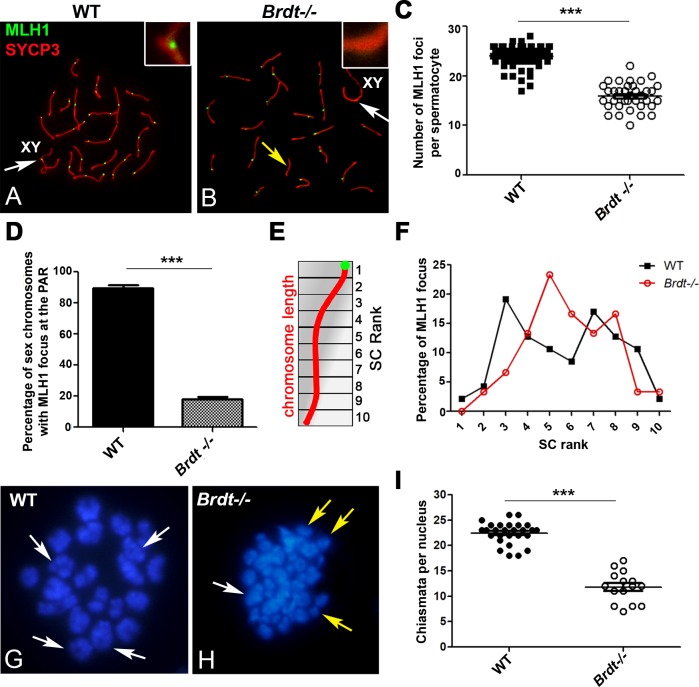
BRDT is required for the formation and distribution of CO during pachynema and chiasmata in metaphase.(A, B) Immunolocalization of MLH1 (green) and SYCP3 (red) in WT (A) and Brdt-/- (B) spermatocytes. Insets enlarge the PAR. White arrow indicates the presence or absence of the MLH1 focus in the PAR. Yellow arrow in (B) indicates autosomes with no MLH1 foci. (C) Quantification of the number of MLH1 foci per nucleus in WT (black squares) and Brdt-/- (white circles) pachytene spermatocytes. ***p<0.0001. Error bars represent standard deviation. Samples were obtained from three mice per genotype. n = 45 and 39 WT and Brdt-/- spermatocytes, respectively. (D) Quantification of sex chromosomes with an MLH1 focus in the PAR in WT (black bar) and Brdt-/- (grey bar) pachytene spermatocytes. ***p<0.0001. Error bars represent standard deviation. Samples were obtained from three each WT and Brdt-/- mice. n = 45 cells per genotype. (E) Scheme representing how each SC (in red) was divided into 10 equal length intervals (SC rank) from the centromere to the distal telomere (centromere is shown in green). (F) Relative distance of localization of each CO focus along autosomes in WT (black squares and line) and Brdt-/- (red circles and line) pachytene spermatocytes. Each point represents the percentage of MLH1 foci in each SC segment. (Samples were obtained from two mice per genotype. n = 15 WT and 15 Brdt-/- spermatocytes). Error bars represent standard deviation. (G,H) Chromosome spreads of diakinesis/metaphase I spermatocytes from WT and Brdt-/- mice stained with DAPI. White arrows show chromosomes with chiasmata. Yellow arrows in (H) show achiasmatic chromosomes. (I) Quantification of the number of chiasmata per nucleus in WT (black circles) and Brdt-/- (white circles) diakinesis/metaphase I spermatocytes (n = 6 and 4 respectively). ***p<0.0001. Error bars represent standard deviation. Samples were obtained from two mice per genotype. n = 4 and 6 WT and Brdt-/- spermatocytes, respectively.